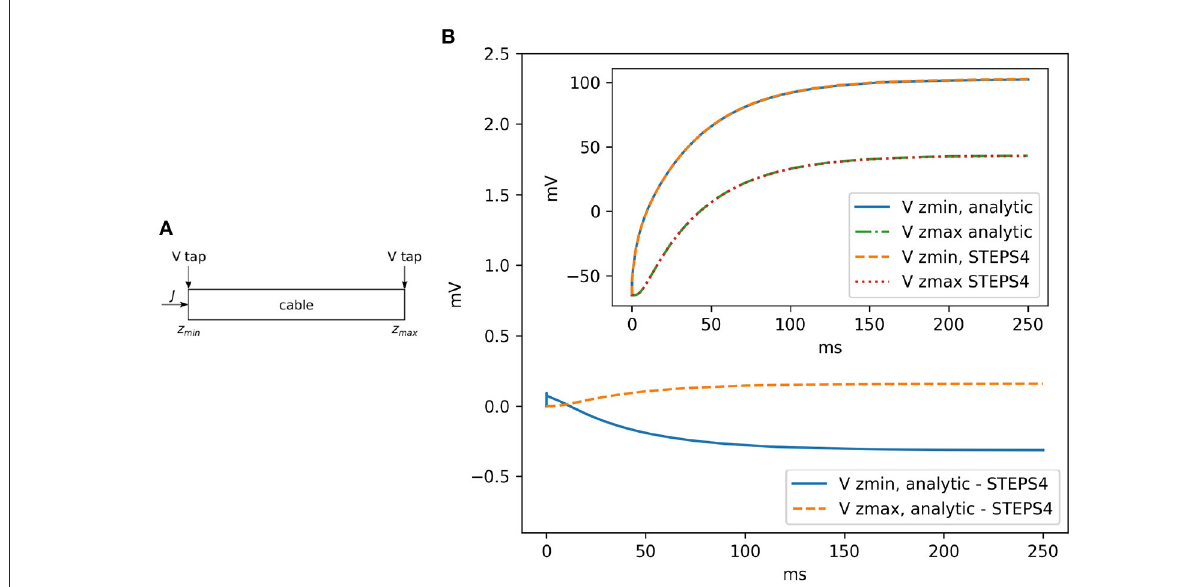
FIGURE4 (A) The general setup for Rallpack 1. Current is introduced into a leaking cable with sealed ends. Voltage is recorded at the extremities (V taps). (B) The voltage difference between the analytic solution and STEPS 4 at z min and z max . The inset shows the overlapping curves.